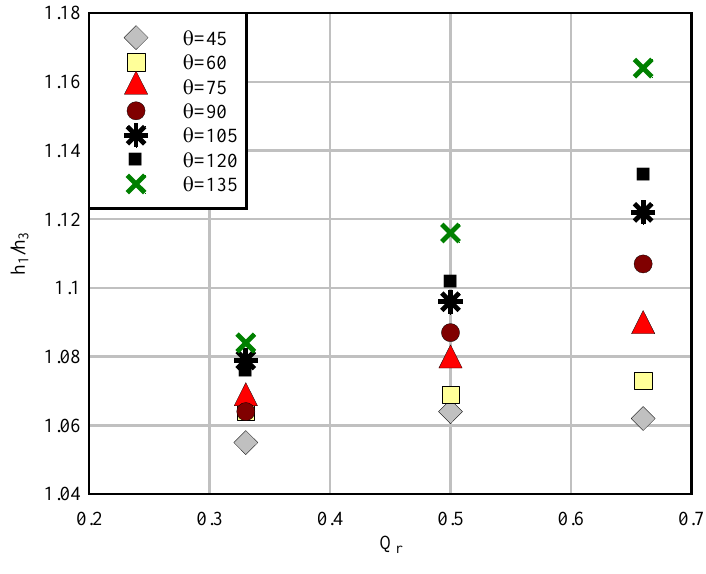
Figure 12. Q r vs. h 1 / h 3 for different θ.